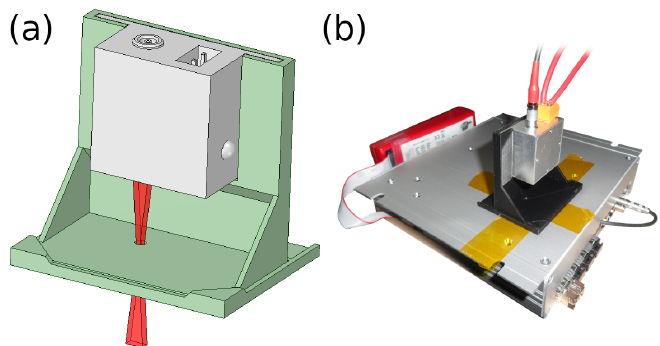
Figure 11. The HOLD evaluation with an IR diode: ( a ) 3D-printed fixture holding the light source; ( b ) complete setup.